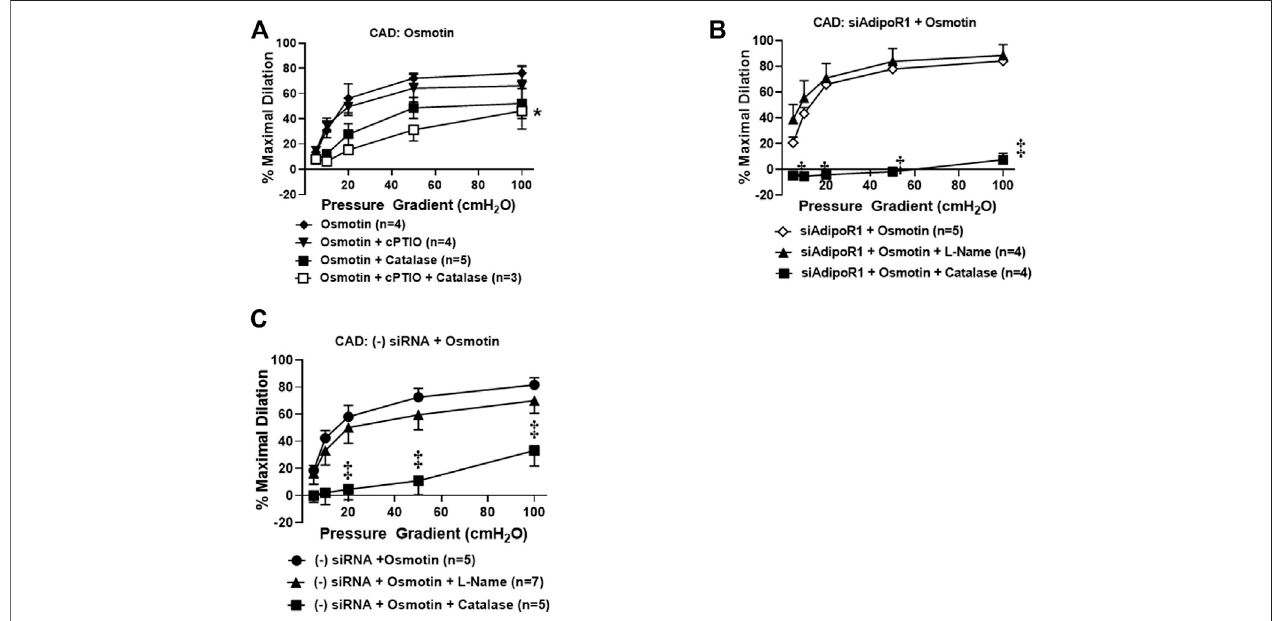
FIGURE4| OsmotinaspotentialactivatorofAdipoR1. (A) FIDinCADarteriolestreatedwithosmotin(0.3 μ M,16 – 20 h)wasnotreducedinthepresenceoftheNO scavenger cPTIO ( n = 4) or PEG-catalase ( n = 5). Signi fi cant reduction of maximal dilation was only observed with both inhibitors ( n = 3, * p < 0.05). (B) The effect of osmotinwaseliminated inarterioles from CADpatientswithreduced expression ofAdipoR1 asPEG-catalase signi fi cantlydecreasedoverall dilation ( n =4) compared to siAdipoR1 and osmotin ( n = 5, ‡ p < 0.01) whereas L-Name had no effect ( n = 4). (C) The primary mediator of FID remains dependent on H 2 O 2 despite osmotin treatment in arterioles treated with negative control siRNA ( n = 5 for both PEG-catalase treated and no inhibitor, ‡ p < 0.01) as opposed to NO ( n = 7; L-Name).